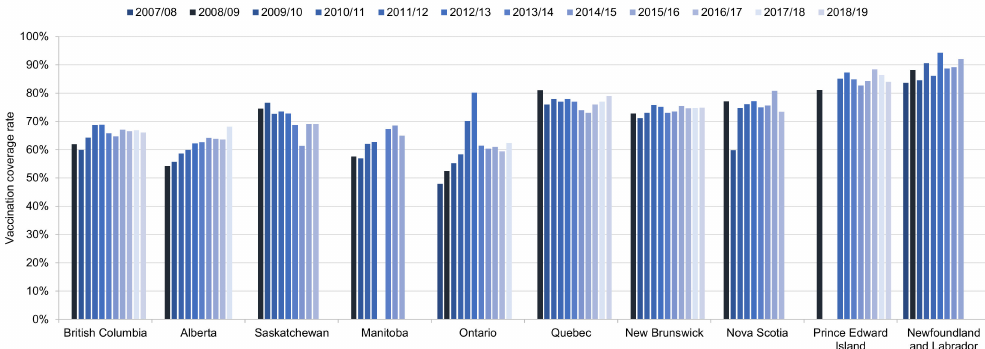
Figure 2. Time trends in HPV vaccination coverage rates in schoolgirls in school years 2007 / 08 to 2018 / 19 in the 10 provinces with data. Vaccination coverage rates are reported for full course of treatment at the time of the vaccination. Vaccination coverage rates may not be comparable across provinces as each province used its own methodology. Source: Canadian Partnership Against Cancer System